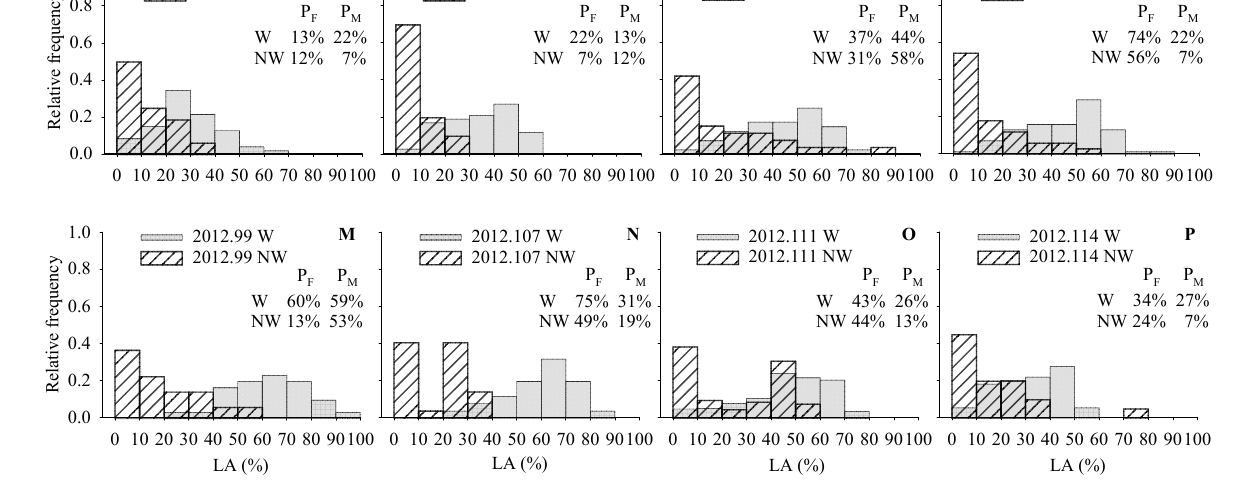
Figure 2. Relative frequency histograms of progeny of 16 families ( A – P ) classified by lesion area (LA) expressed as percentage of the fruit that was affected by the brown rot lesion, on wounded (W) and non-wounded (NW) fruits. The mean values of female (P f ) and male (P m ) parents for each population are indicated. Embrapa Peach Breeding Program, 2015–2016, 2016–2017 and 2017–2018 growing seasons, Pelotas, Rio Grande do Sul, Brazil. Progeny: 2008.159 ( A ), 2009.38 ( B ), 2012.26 ( C ), 2012.43 ( D ), 2012.49 ( E ), 2012.61 ( F ), 2012.52 ( G ), 2012.66 ( H ), 2012.68 ( I ), 2012.88 ( J ), 2012.31 ( K ), 2012.46 ( L ), 2012.99 ( M ), 2012.107 ( N ), 2012.111 ( O ) and 2012.114 ( P ). The 2012.52 and 2012.66 progeny (Figure 2G,H), grouped the highest percentage of seedlings in the first two categories of LA (58 and 35%, respectively) when the fruits were W, and under NW treatment all genotypes of these progeny, together with the 2012.61 progeny (Figure 2F), were grouped within the first two categories (0–10 and 10–20% of the area affected by lesion). The parents of 2012.52 and 2012.66 progeny (Conserva 947 and Conserva 1600) had the lowest means of LA for both W fruits (12 and 19% respectively) and NW treatment (4 and 3%, respectively). Conserva 672 selection, one of the parents of 2012.61 progeny, also presented low LA value (19 and 7%, for W and NW fruits,